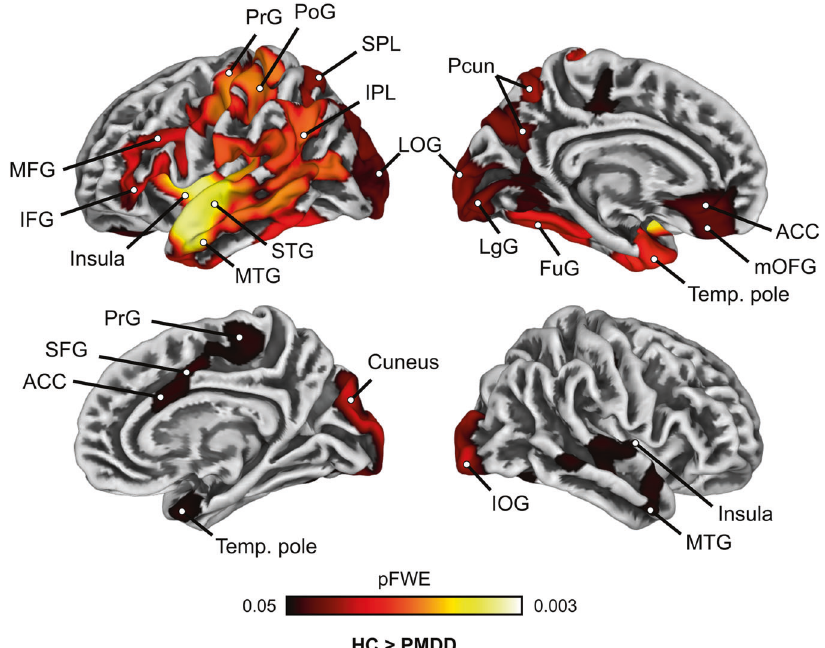
Fig. 2 Whole-brain group comparison of cortical thickness between women with premenstrual dysphoric disorder and healthy controls ( p FWE < 0.05, TFCE). Surface representation of the signi fi cant clusters showing thinner cortex in women with PMDD compared to healthy controls across the whole brain. No signi fi cant group difference in the opposite direction was found. ACC anterior cingulate cortex, FuG fusiform gyrus, FWE Family Wise Error correction, IFG inferior frontal gyrus, IOG inferior occipital gyrus, IPL inferior parietal lobule, LgG lingua gyrus, LOG lateral occipital gyrus, MFG middle frontal gyrus, mOFG medial orbitofrontal gyrus, MTG middle temporal gyrus, PHG parahippocampal gyrus, PoG postcentral gyrus, PrG precentral gyrus, SFG superior frontal gyrus, SPL superior parietal lobule, STG superior temporal gyrus, Temp temporal, TFCE Threshold Free Cluster Enhancement, PMDD premenstrual dysphoric disorder, HC healthy